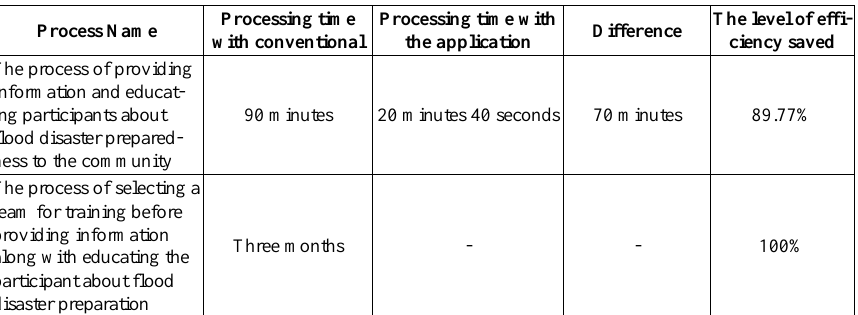
Table 7. Effectiveness based on time